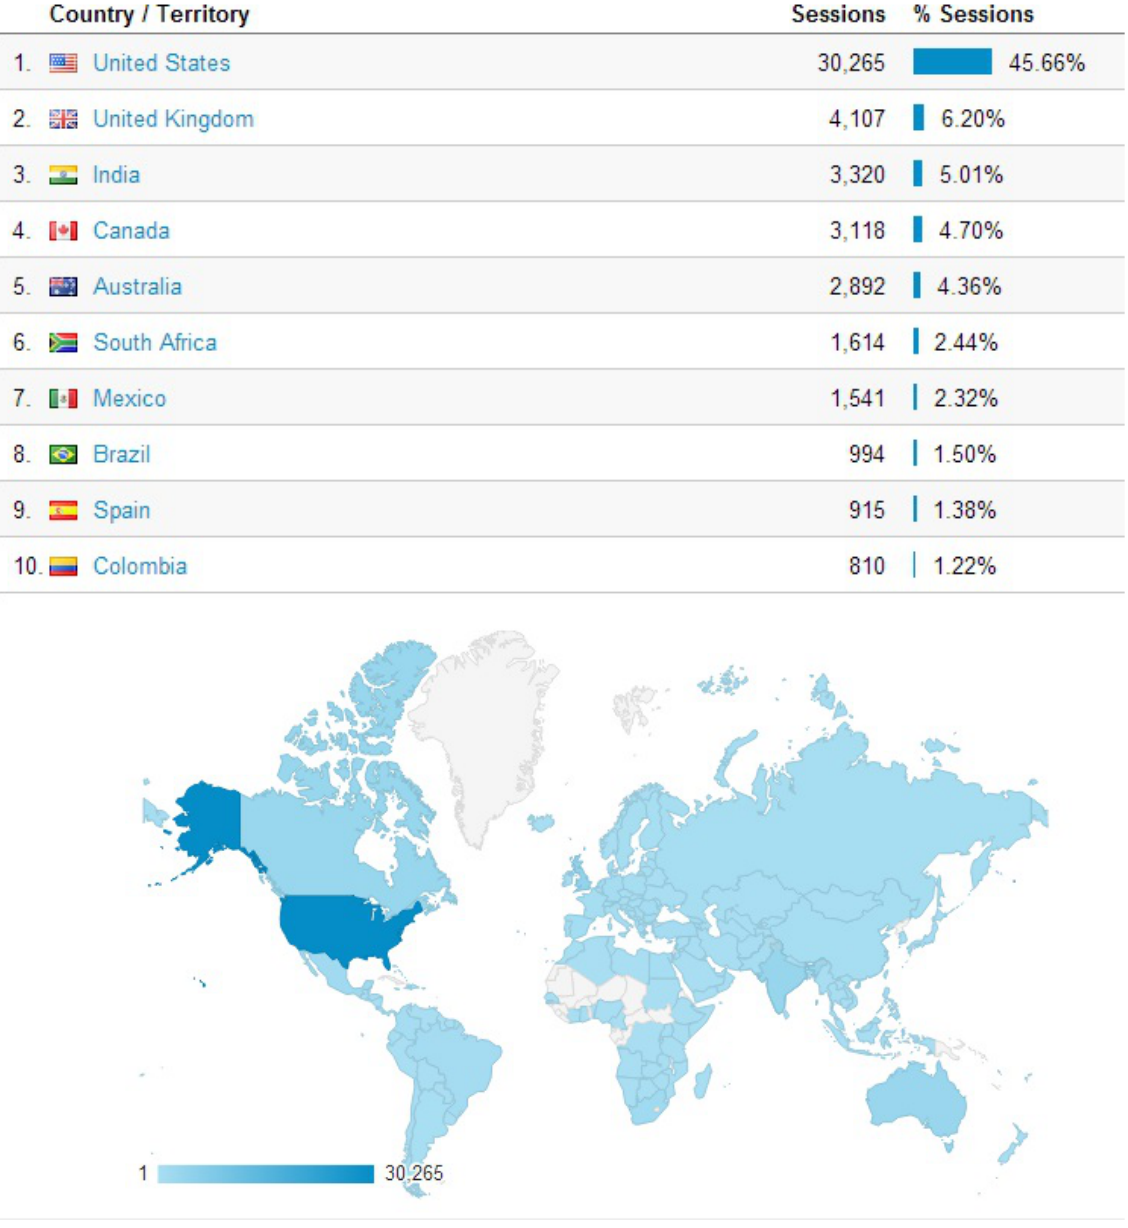
Figure 4. (a) The top ten countries where the largest number of students taking Astronomy – State of the Art live, from Google Analytics. Relative to their populations, the United States, the U.K., and Canada are about equally represented and three of the top ten countries are Spanish- speaking. (b) A world map of students in the course shows representation from every continent except Antarctica, 174 countries in all. Some students manage to take the class even though they live in places with poor Internet